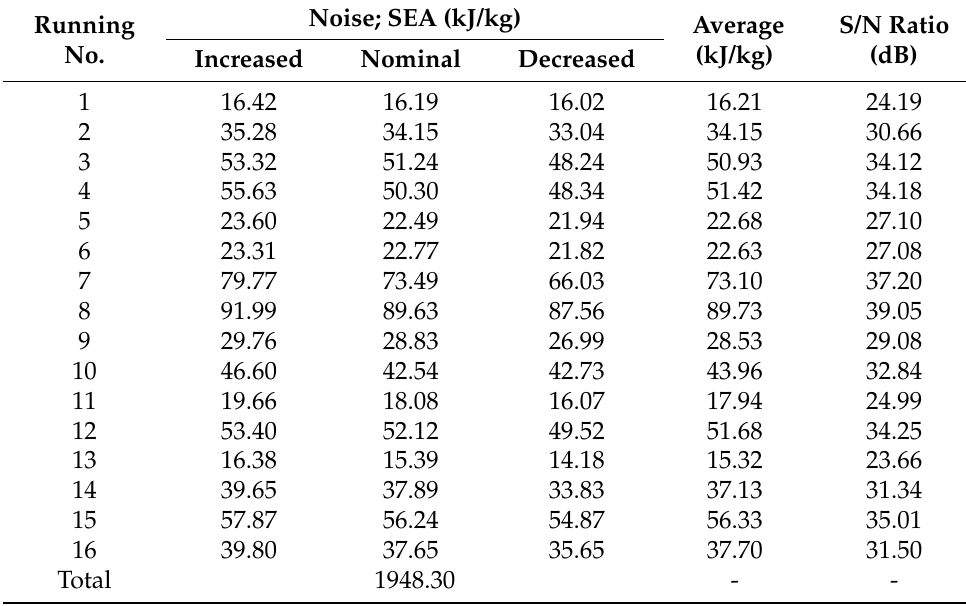
Table 5. SEA Results from Simulations Based on Taguchi Design of Experiment.